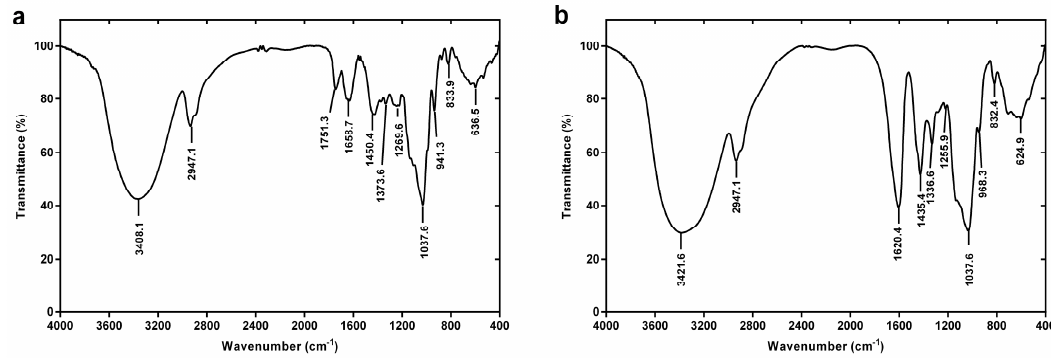
Figure 2. FT-IR spectra: ( a ) DRP1, ( b ) DRP2.